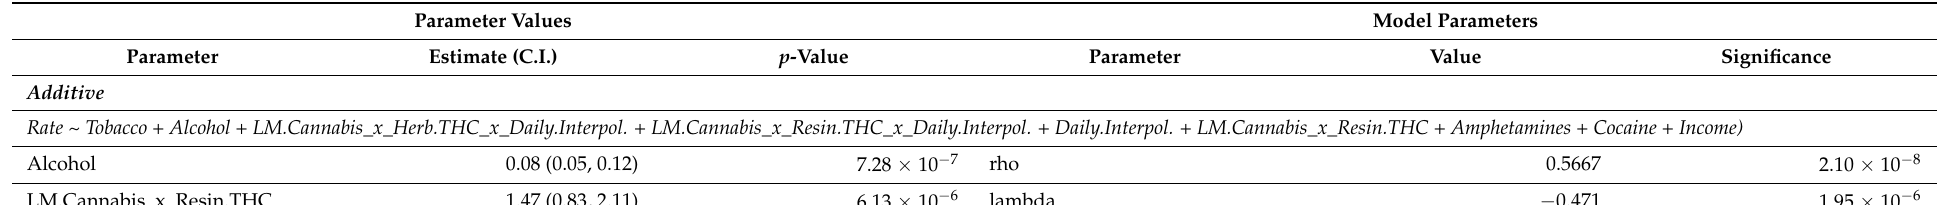
Table 2. Multivariate Geospatial Regression for Chromosomal